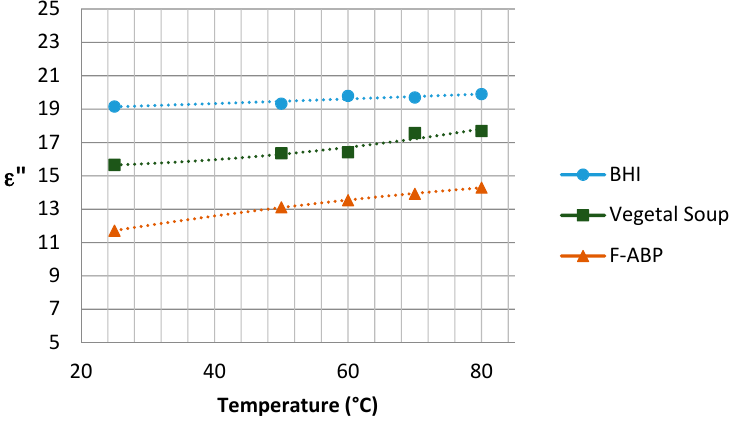
Figure 6. Loss factor for the samples under study near 2.45 GHz.